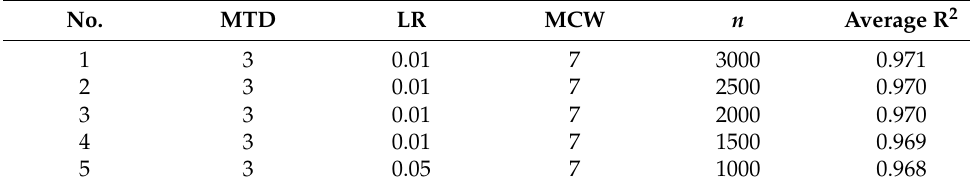
Table 5. Top five R 2 for MTD, LR, MCW and n, determined with cross-validation. No. MTD LR MCW